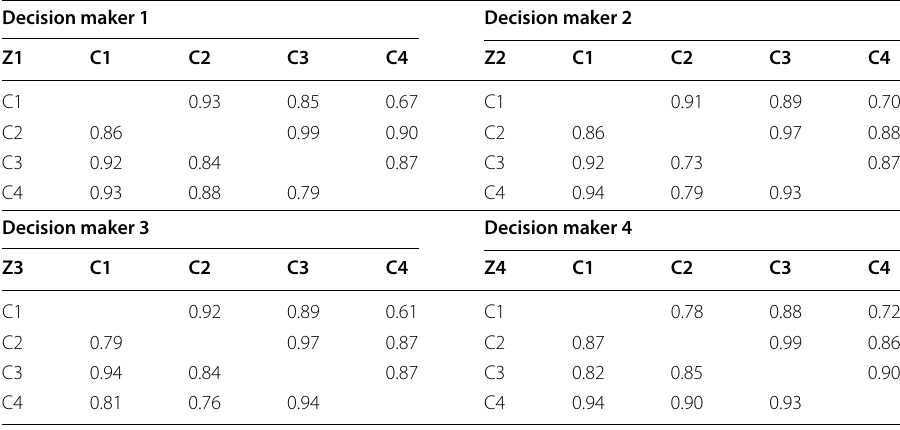
Table 8 Consensual fuzzy preference degrees for the equity-based crowdfunding alternative